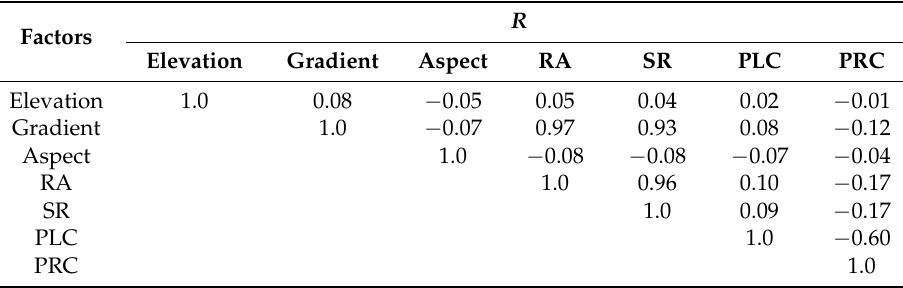
Table 2. Correlation analyses between topographical factors.